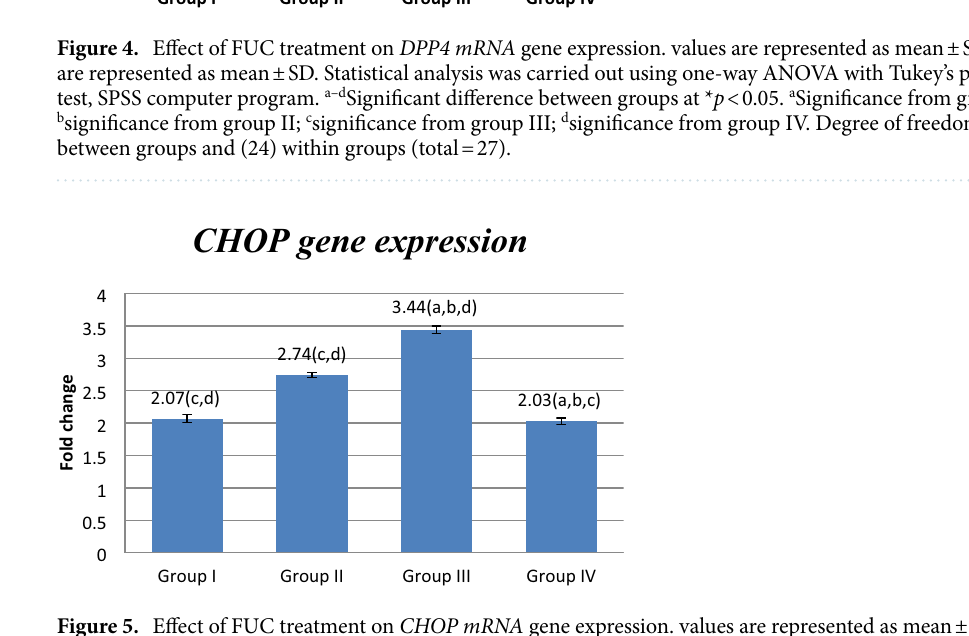
Figure 5. Effect of FUC treatment on CHOP mRNA gene expression. values are represented as mean ± SD. Data are represented as mean ± SD. Statistical analysis was carried out using one-way ANOVA with Tukey’s post hoc test, SPSS computer program. a–d Significant difference between groups at * p < 0.05. a Significance from group I; b significance from group II; c significance from group III; d significance from group IV. Degree of freedom is (3) between groups and (24) within groups (total =